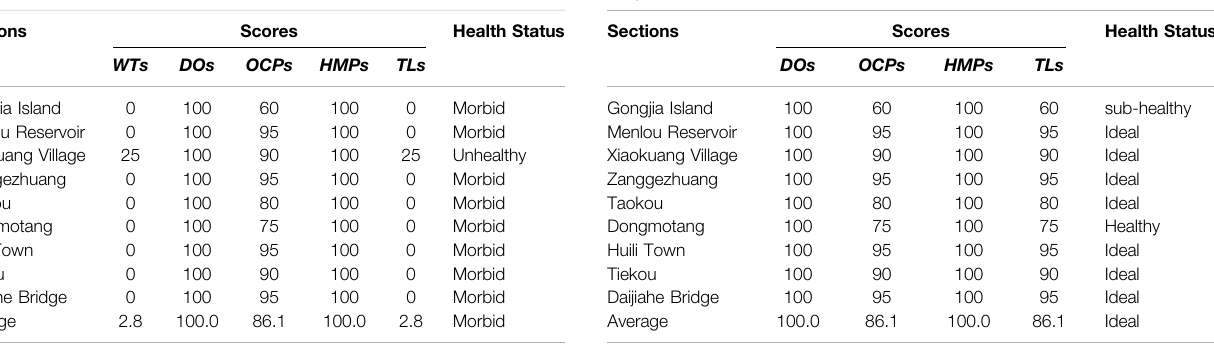
TABLE 10 | Results of grading and health assessment excluding water temperature